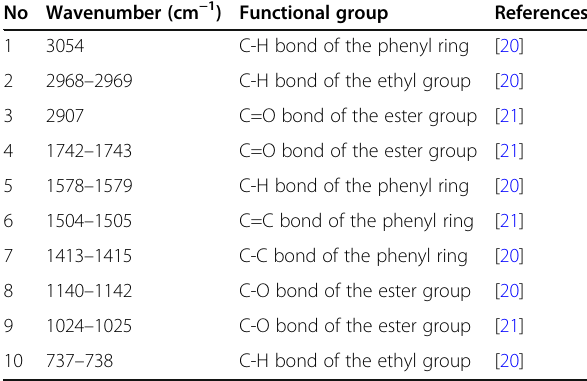
Table 2 Interpretation of FTIR spectra of membranes from PET bottle and PET resin No Wavenumber (cm − 1 ) Functional